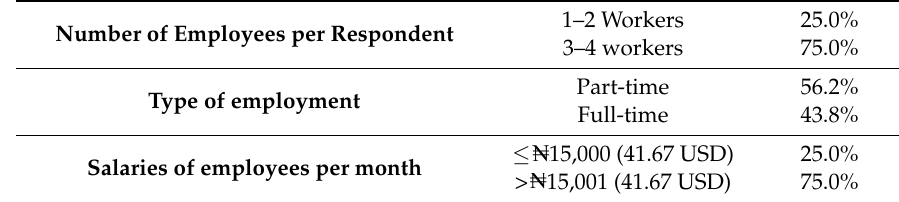
Table 3. Employment generated through fish farming in Jos.